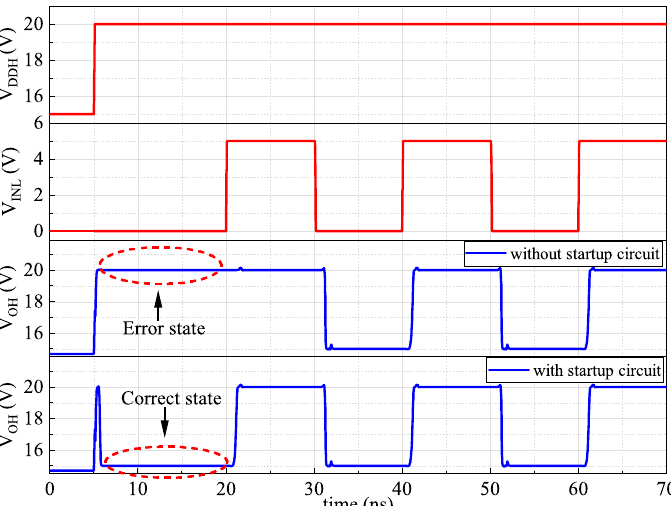
Figure 9. The output state of proposed FHV-LS with and without the start-up circuit during V DDH